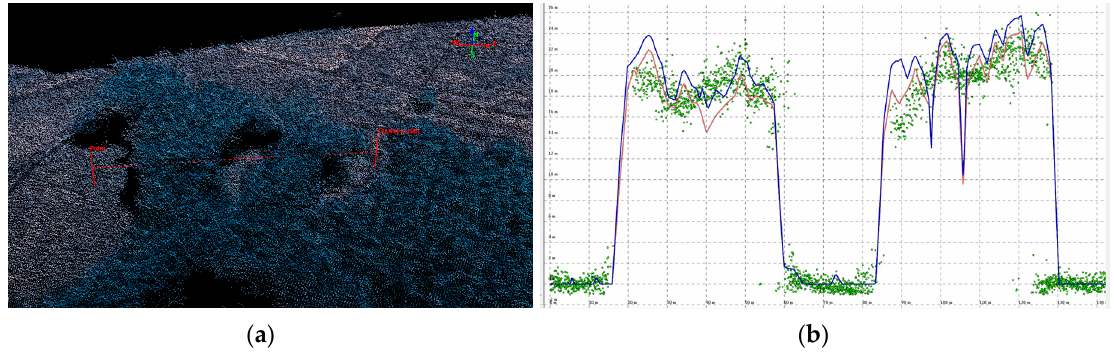
Figure 5. An example of the image-matched point cloud from Pléiades images at the Remningstorp test site. ( a ) 3D visualization with points coloured from the ortho-rectified image; ( b ) Profile along the dotted line in the left image. Green describes image-matched points and the lines represent ALS p90 (orange) and ALS p100 (blue) computed at 2 m resolution. The heights range from 0 to 26 m.